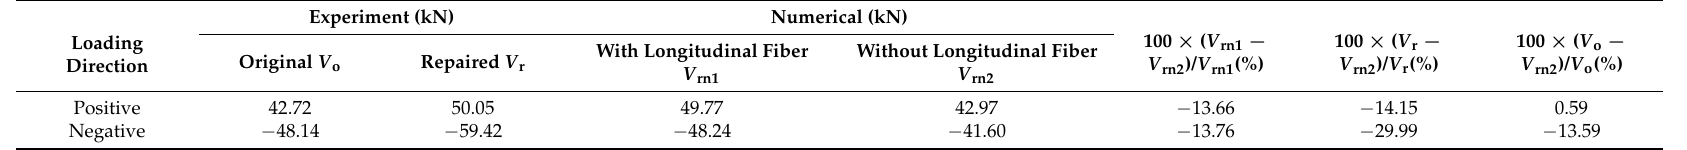
Table 11. Comparison of experimental and numerical maximum lateral strength for column